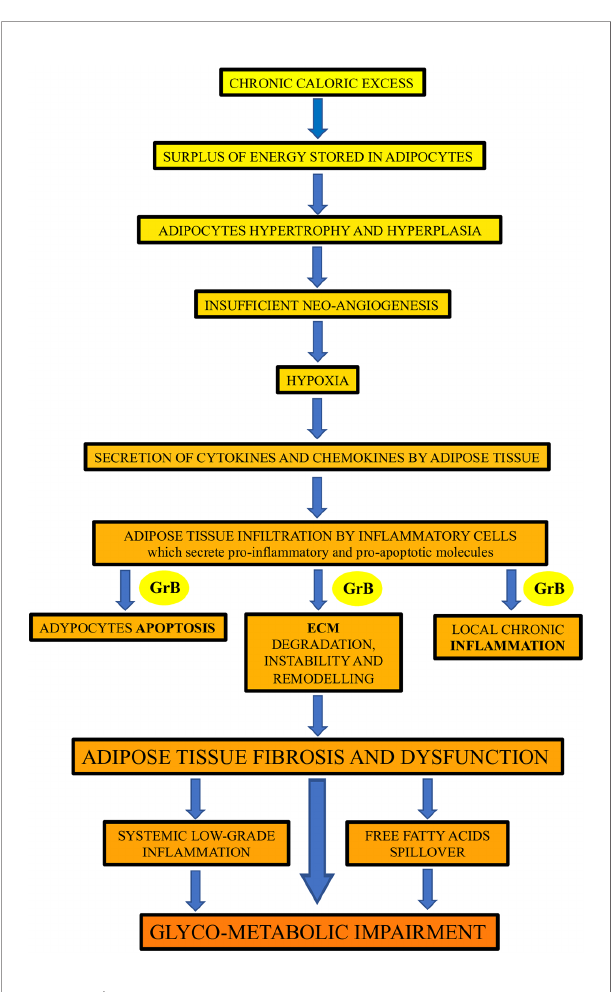
FIGURE 2 | The potential contribution of Granzyme B (GrB) to the in fl ammation and dysfunction of adipose tissue in obese subjects. GrB, produced by different adipose tissue in fi ltrating in fl ammatory cells, may contribute to the promotion of the apoptotic, in fl ammatory and extracellular matrix (ECM) remodeling processes occurring in adipose tissue in obesity, leading to adipose tissue fi brosis and dysfunction, and driving up to glyco- metabolic